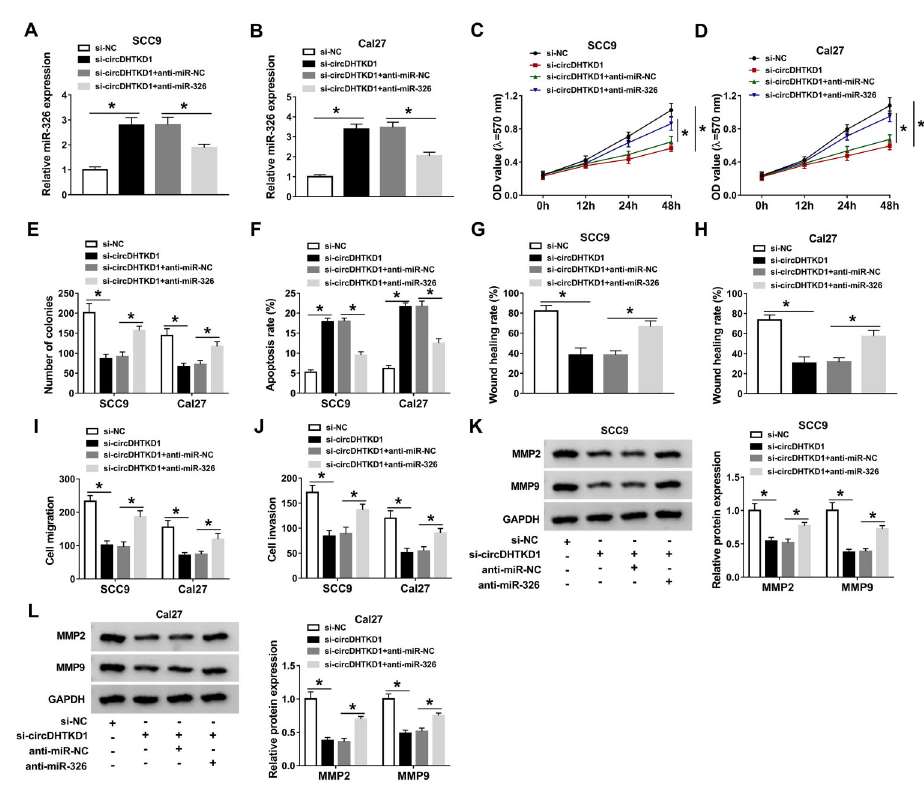
Figure 4. Inhibition of miR-326 partly restored the cancer-inhibitory function of downregulated circDHTKD1 in oral squamous cell carcinoma (OSCC) cells. A and B , The miR-326 level was measured through qRT-PCR after transfection of si-NC (negative control), si-circDHTKD1, si-circDHTKD1 + anti-miR-NC, and si-circDHTKD1 + anti-miR-326. Cell viability ( C and D ) and clonal capacity ( E ) were evaluated using MTTand colony formation assay. ( F ) The detection of cell apoptosis was completed via fl ow cytometry. Cell metastasis was assessed by wound healing and transwell assay for migration ( G – I ), as well as transwell assay and western blot for invasion ( J – L ). Three biological and three technical replicates were performed in each assay. Data are reported as means ± SD. *P o 0.05 (one-way ANOVA followed by Tukey ’ s